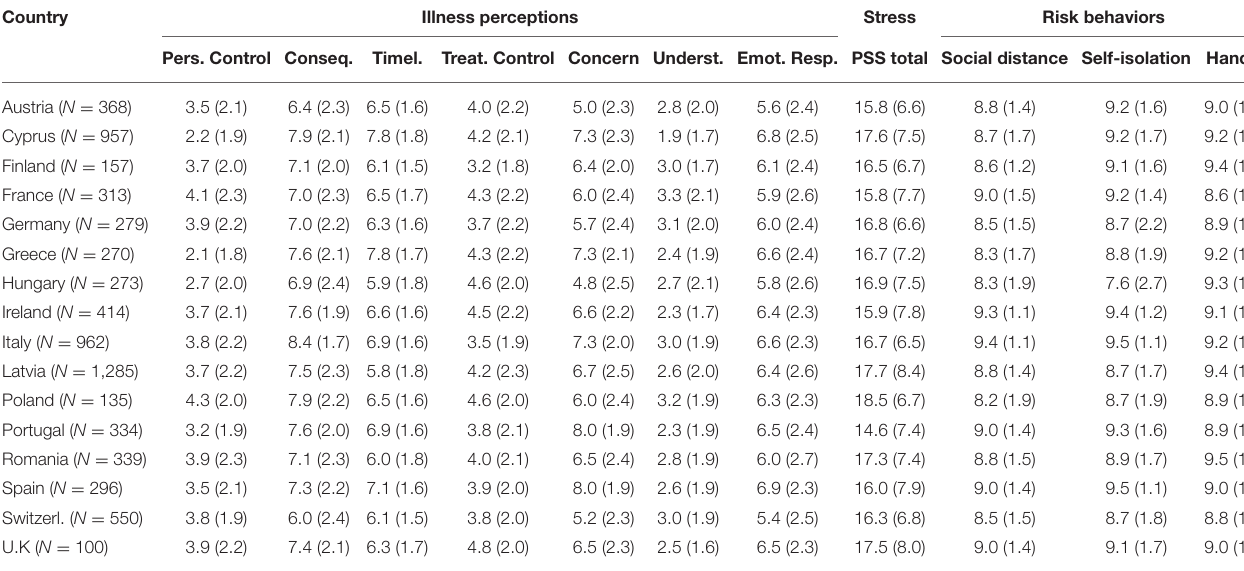
TABLE 1 | Means (and Standard Deviations) for the outcome variables across country. Country Illness perceptions Stress Risk behaviors